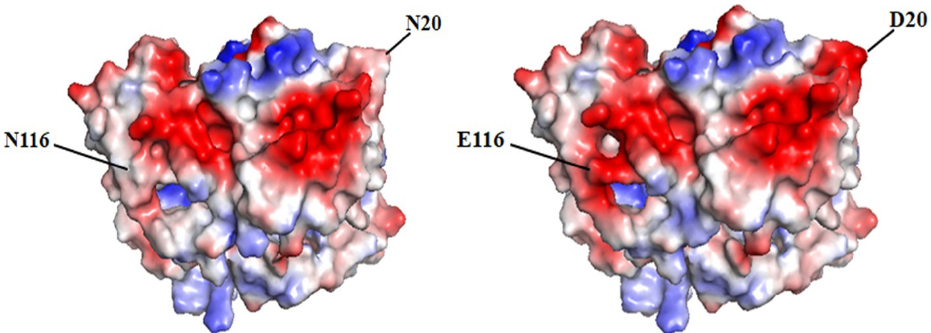
Figure 1. Predicted mutation sites in the wide-type BsNOX structure.